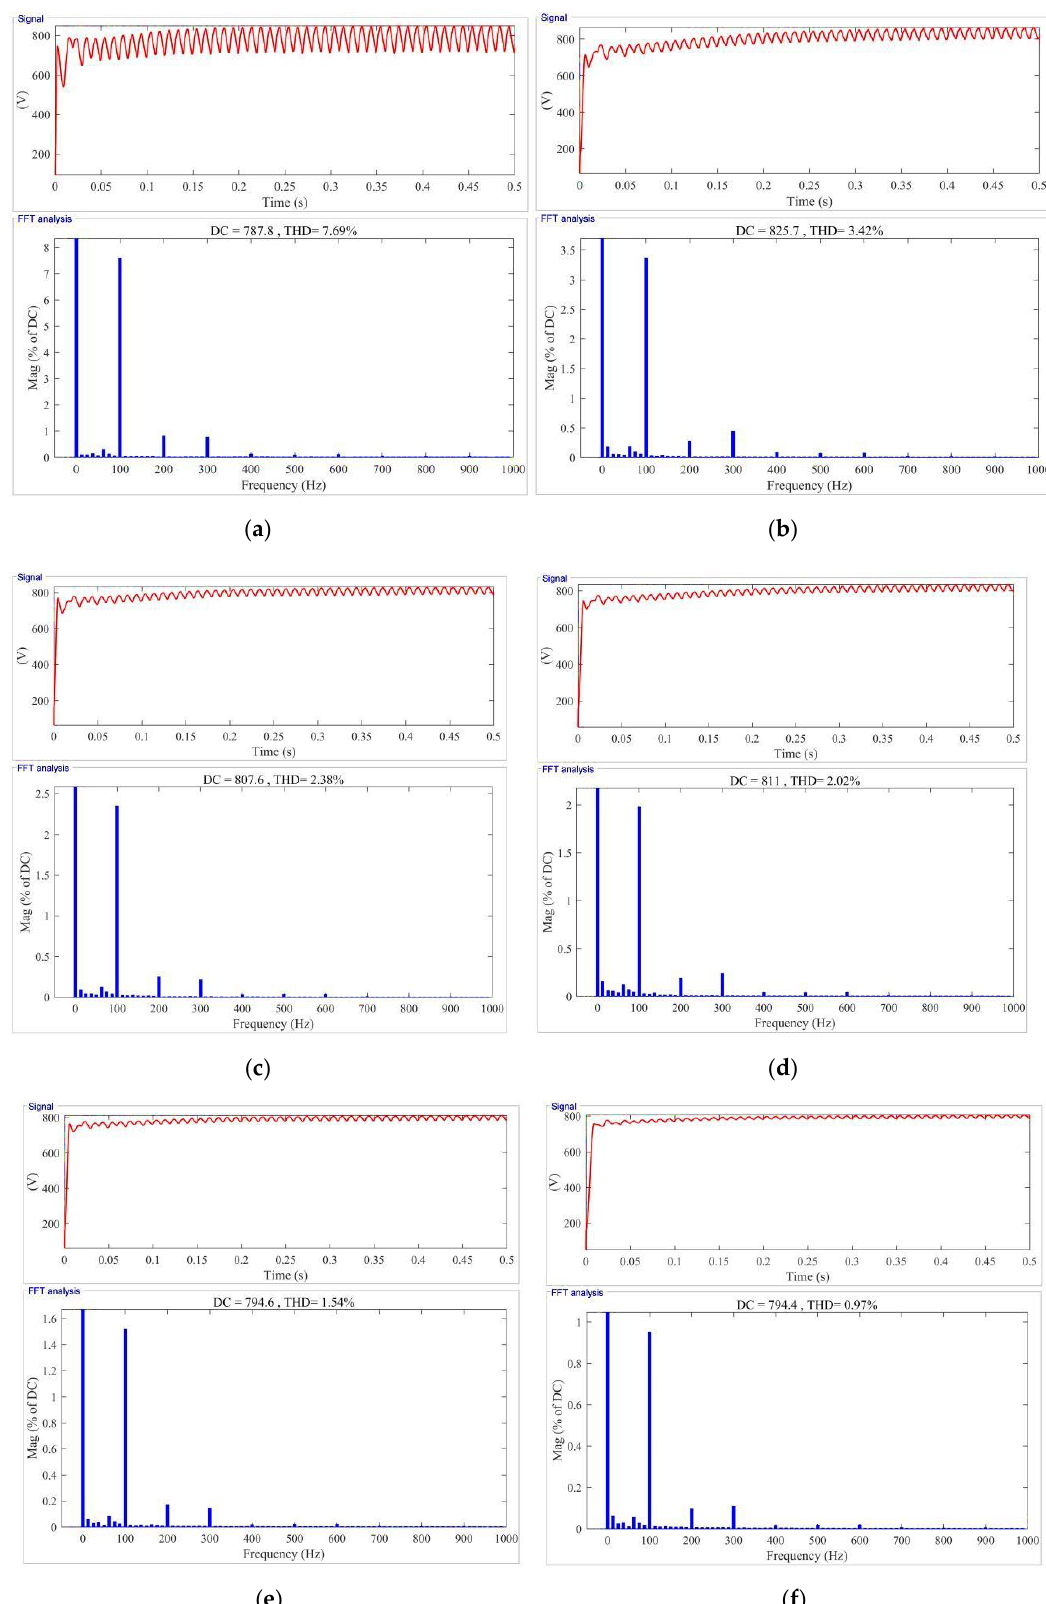
Figure 10. Fourier analysis of voltage waveforms. ( a ) N = 0; ( b ) N = 100; ( c ) N = 200; ( d ) N = 300; ( e ) N = 400; ( f ) N =